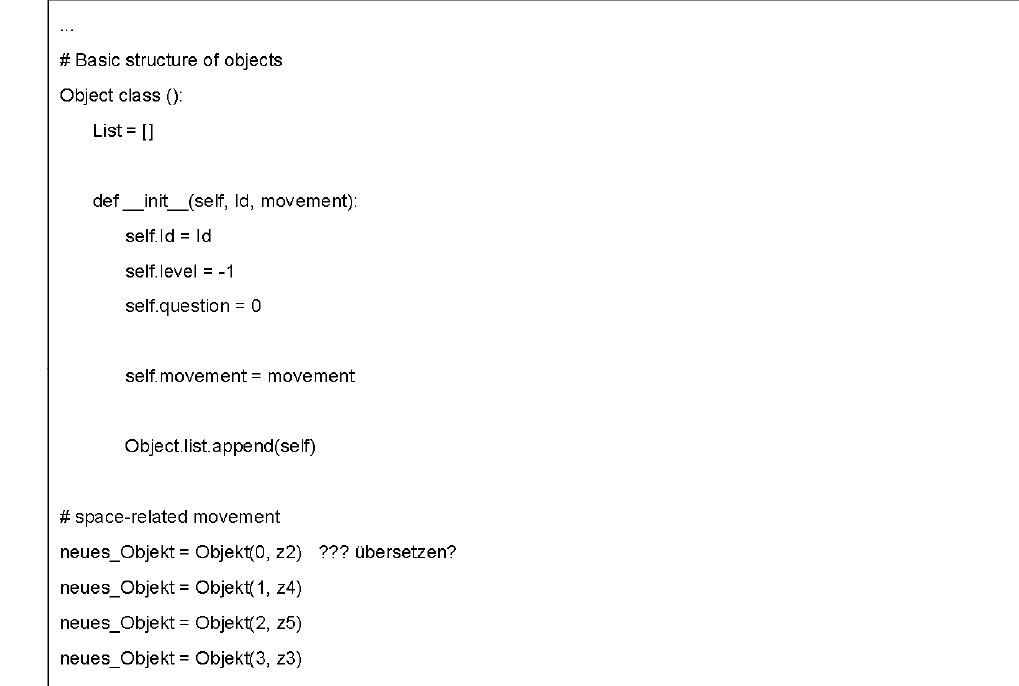
Figure 6. Script of spatial model of cultural meaning. Only the angles of the different joints of the robot were predefined as the starting point.